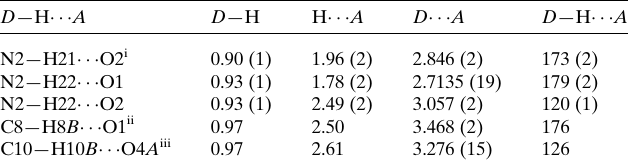
Table 4 Hydrogen-bond geometry (A˚ , (cid:5) ) for 5